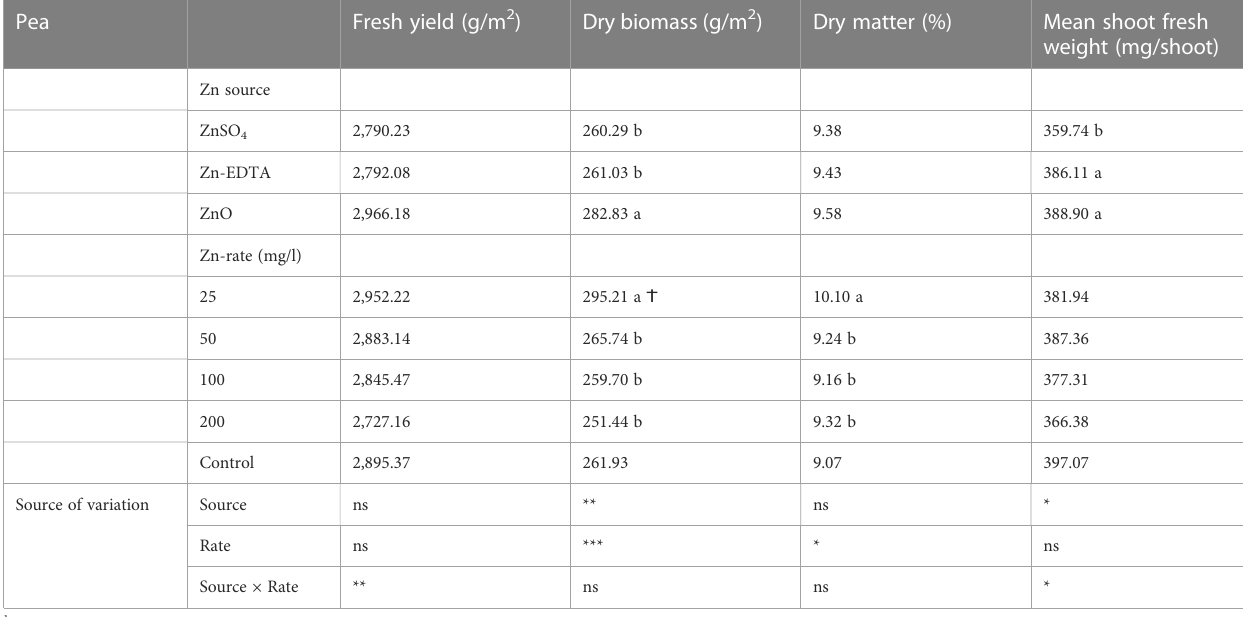
TABLE 1 Effect of seed soaking with different Zn sources and application rates on fresh yield (g/m 2 ), dry biomass (g/m 2 ), dry matter content (%), and mean shoot fresh weight (mg/shoot) of pea microgreens. 1